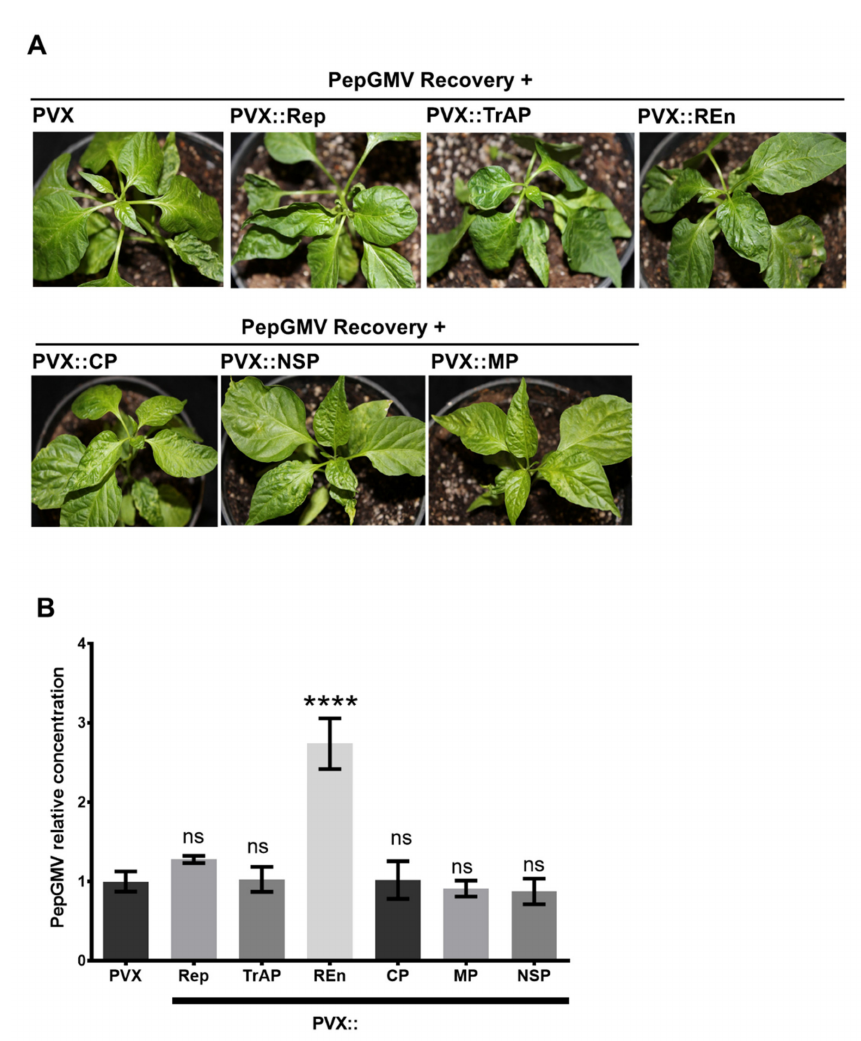
Figure 4. E ff ect of the expression of individual PHYVV genes in recovered PepGMV plants. ( A ) PepGMV recovered plants were inoculated with a PVX-vector expressing PHYVV individual genes. Ten days after inoculation, plant phenotype was analyzed and apical tissue collected for viral DNA quantification. ( B ) PepGMV DNA accumulation. PepGMV DNA levels were quantified by qPCR using the host gene CaEF1a for internal normalization. DNA concentration from di ff erent samples is expressed in reference to the value obtained with plant inoculated with PVX empty vector. Bars represent mean values of three independent biological replicates. Each replica is a pool of five plants. Error bars plotted to refer to the standard deviation of the mean. Asterisks indicate samples that are statistically di ff erent from the PVX empty vector sample (**** p < 0.0001; ns, not significant) determined by Dunnett’s multiple comparisons